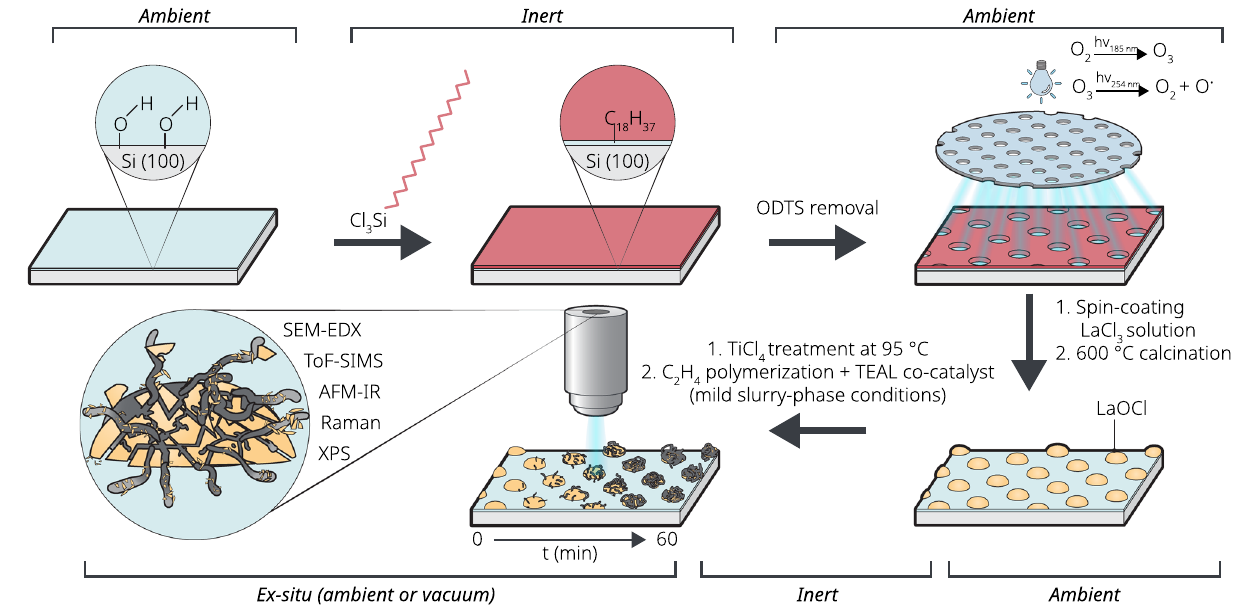
Fig.1|SchematicrepresentationofthesynthesisrouteofLaOClsphericalcaps on a surface modi fi ed Si(100) wafer. Chemical modi fi cation of the Si(100) wafer surface, to generate hydrophilic circular patches (about 40 μ m in diameter) separated by hydrophobic bars, is achieved through sequential grafting of the hydrophobic octadecyltrichlorosilane (ODTS) on a hydroxylated surface and selective etching with a photomask and UV/O 3 . Subsequent spin-coating and